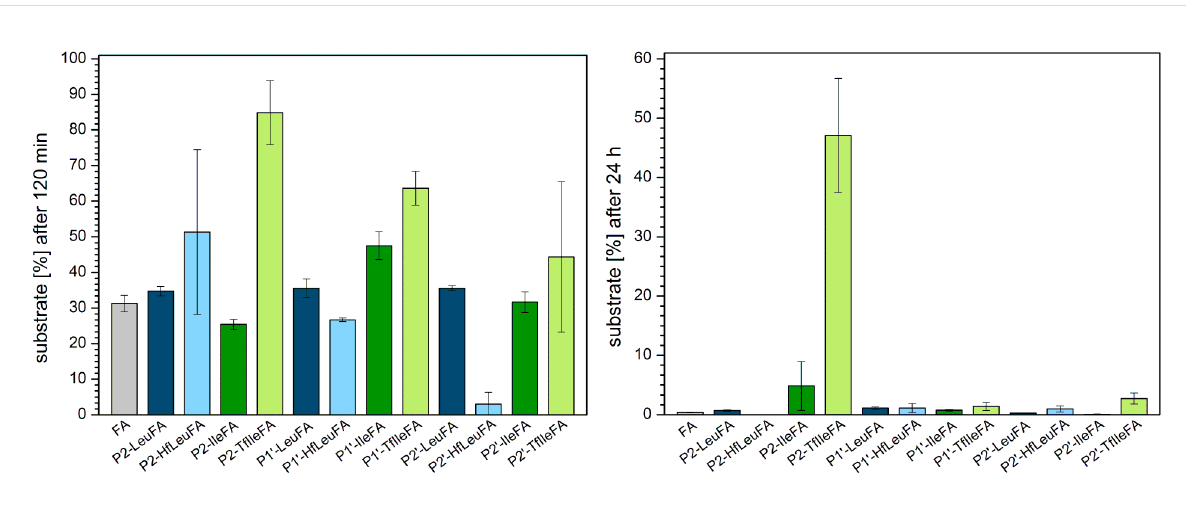
Figure 8: Percentage of substrate remaining after incubation for 120 min (left) and 24 h (right) with proteinase K in 50 mM Tris/HCl buffer, containing 10 mM CaCl 2 pH 7.5, at 37 °C. The data shown represent the mean of three independent measurements. Errors are derived from the standard devia-